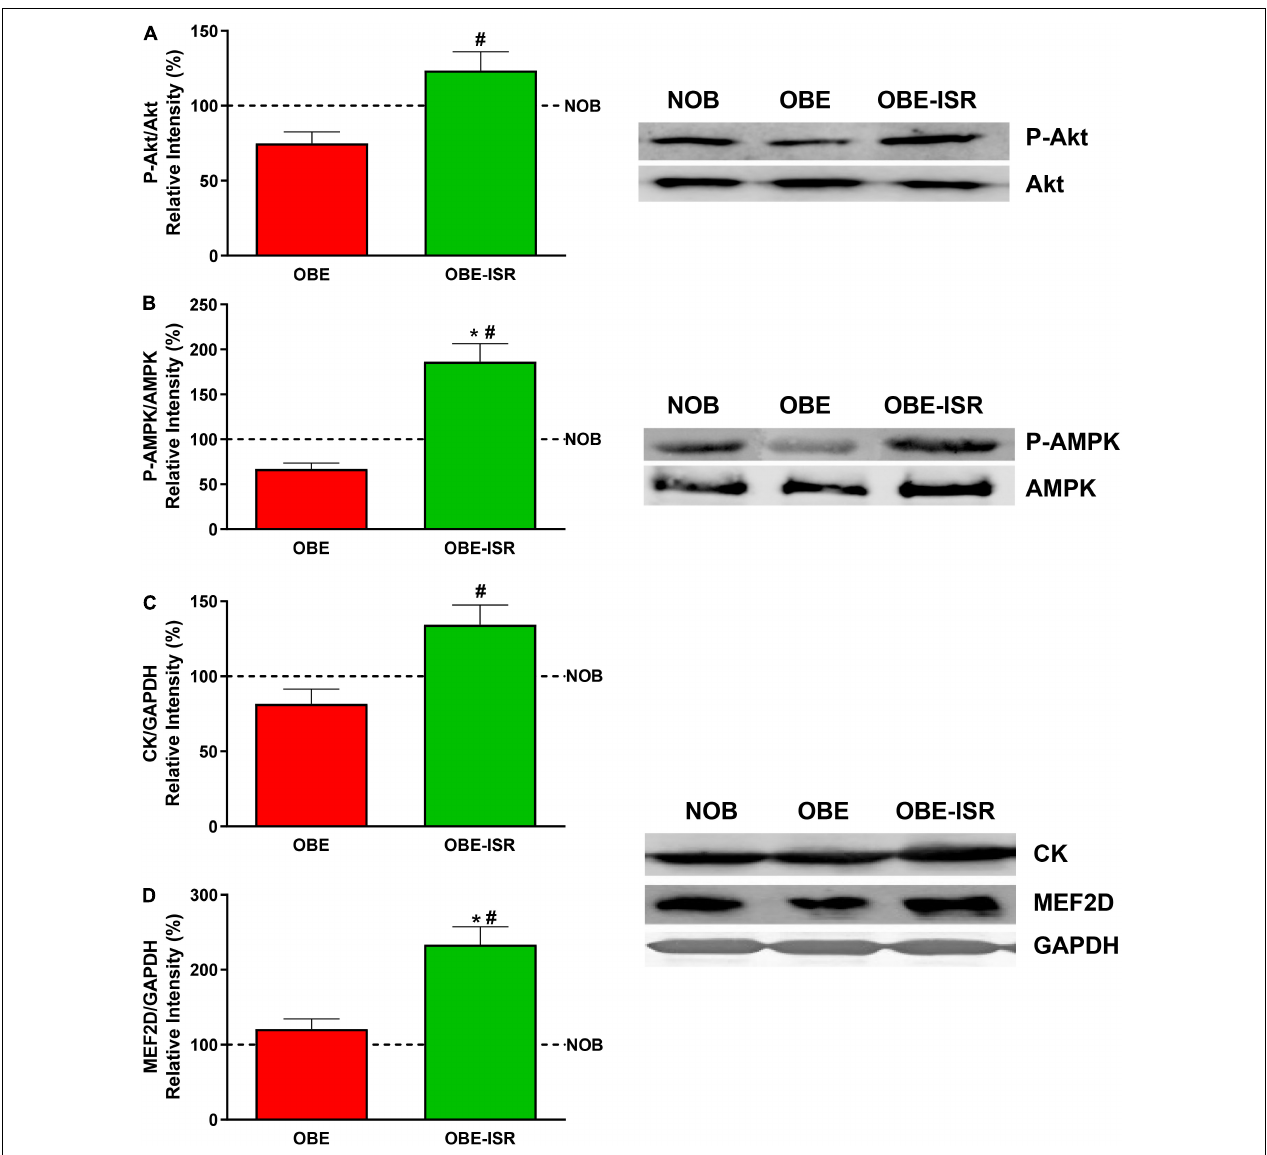
FIGURE 7 | Activation of key signaling elements and expression of differentiation markers in the muscle. (A) p-Akt. (B) p-AMPK. (C) CK. (D) MEF2D. Rats were fed a normal rodent diet (NOB) or a high-fat diet (HFD) formulated with rapidly (OBE) or with slowly digestible carbohydrates (OBE-ISR). Data expressed as mean ± SEM. *Significant difference with NOB group, p < 0.05. #Significant difference with OBE group, p <